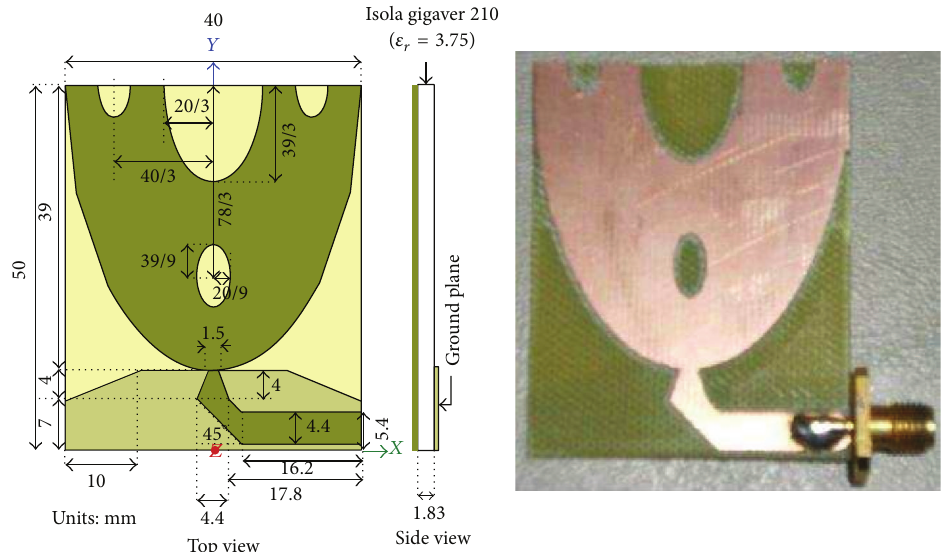
Figure 1: Configuration and photo of the UWB antenna in [42]. The antenna combines several bandwidth enhancement techniques.